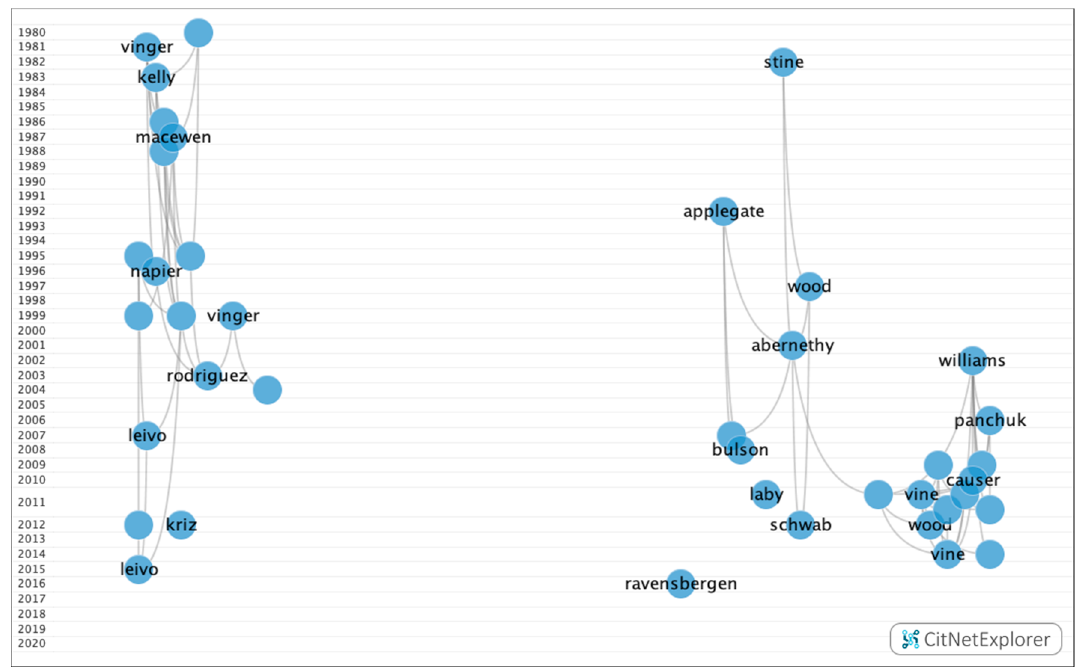
Figure 11. Core publications in the citation network about multifocal IOLs.